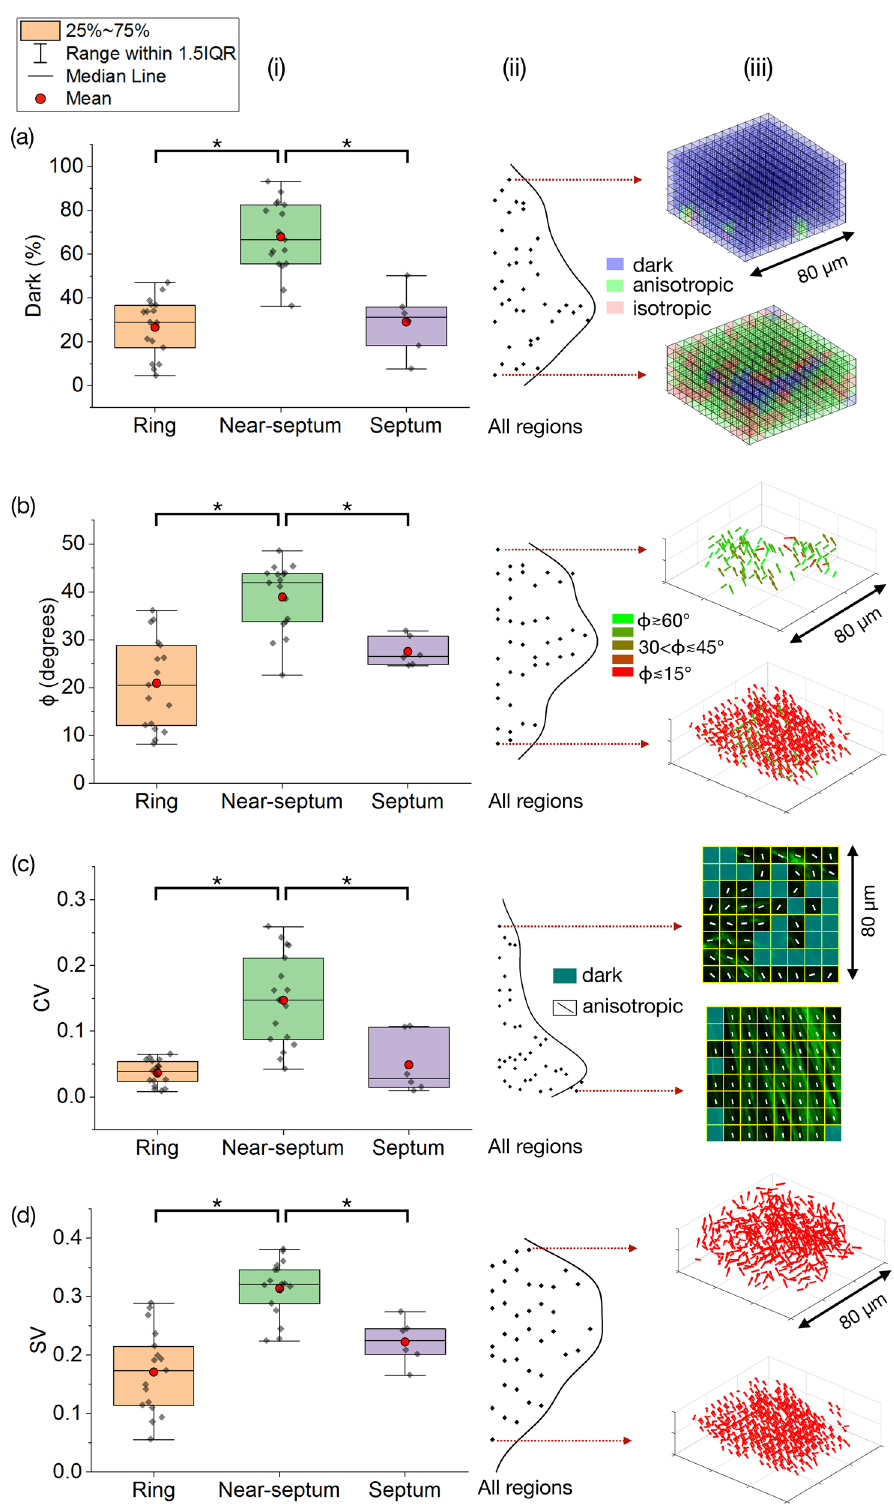
Figure 3. Comparison between the four SHG imaging parameters in the ring, near-septum and septum. The SHG imaging parameters are ( a ) dark, ( b ) out-of-plane fibers, , ( c ) CV, and ( d ) SV. (i) Numerical values in box and whisker plots. (ii) Smooth kernel distribution of the data together from all three regions. (iii) Representative ϕ FT-SHG analysis results illustrate the physical meaning of the parameters. Asterisk (*) indicates significant differences ( p <